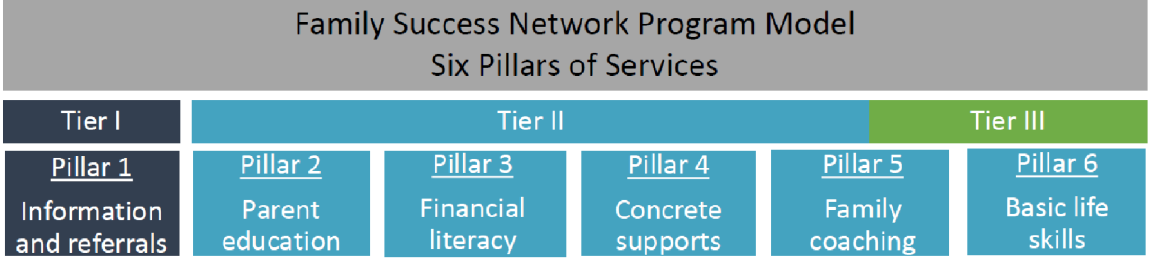
Figure 1. The Family Success Network Program Model.